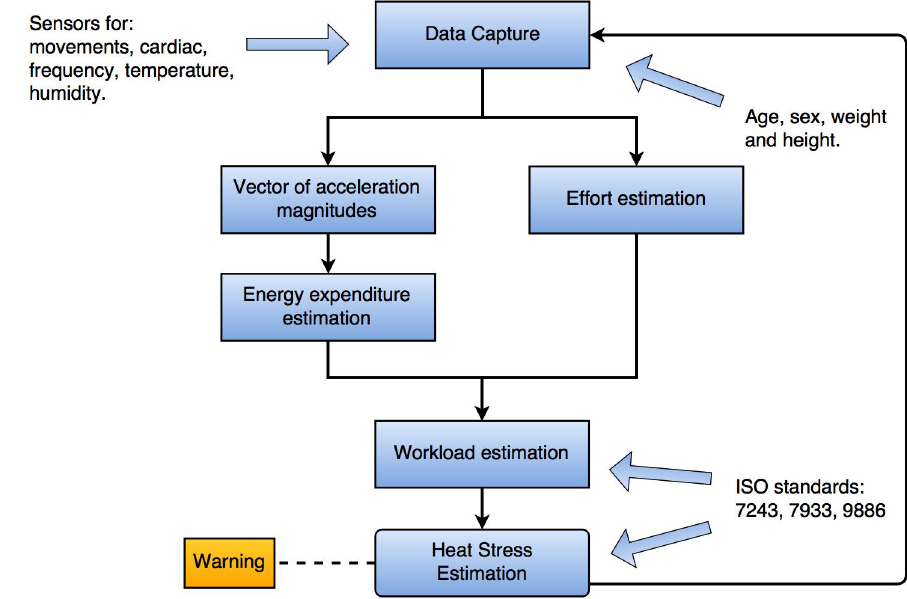
Figure 1. Proposed heat stress estimation